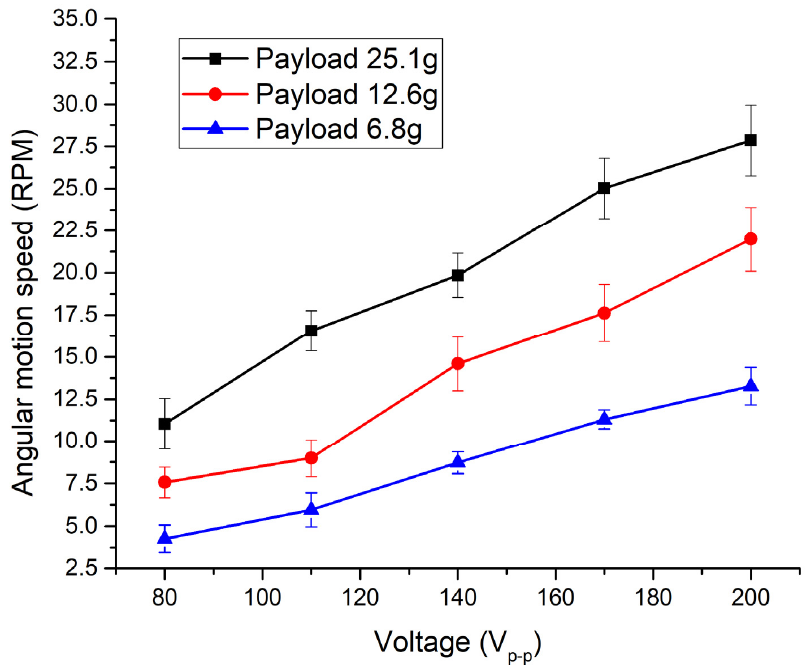
Figure 18. Measured angular motion speed of the robot at different payloads when segment R 0deg is exited.